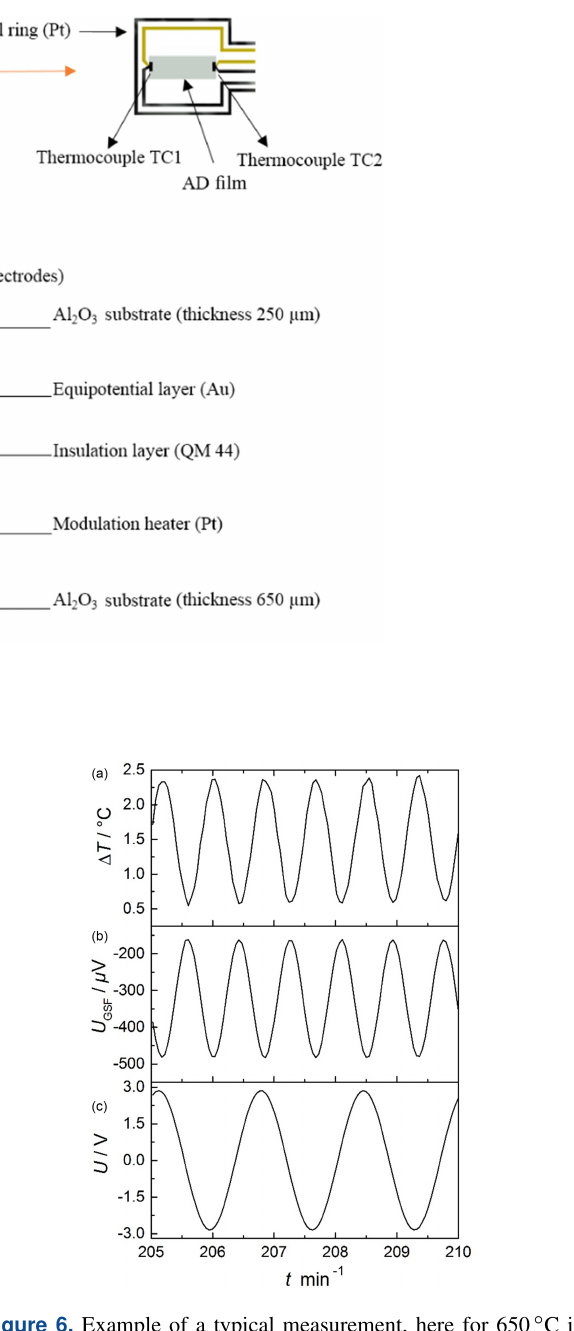
Figure 6. Example of a typical measurement, here for 650 ◦ C in O 2 : raw signal of the applied sinusoidal voltage by the function generator U (c) , thermovoltage of the gas sensitive film U GSF (b) , and temperature difference (cid:49)T (a)